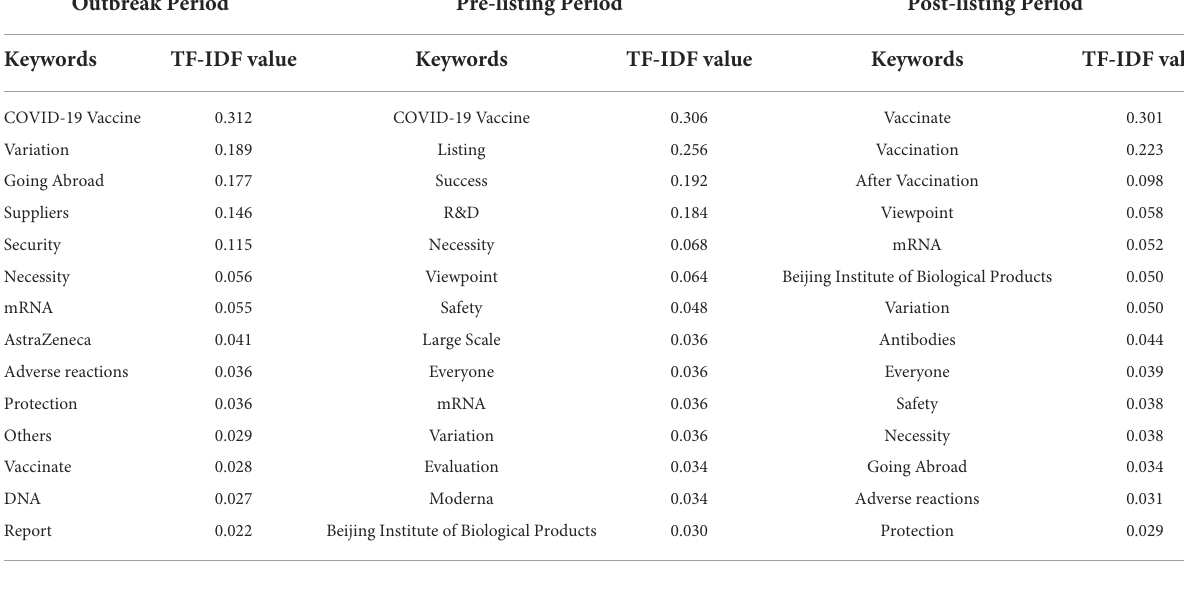
TABLE 3 Keywords of the public information need of COVID-19 vaccine in different periods.